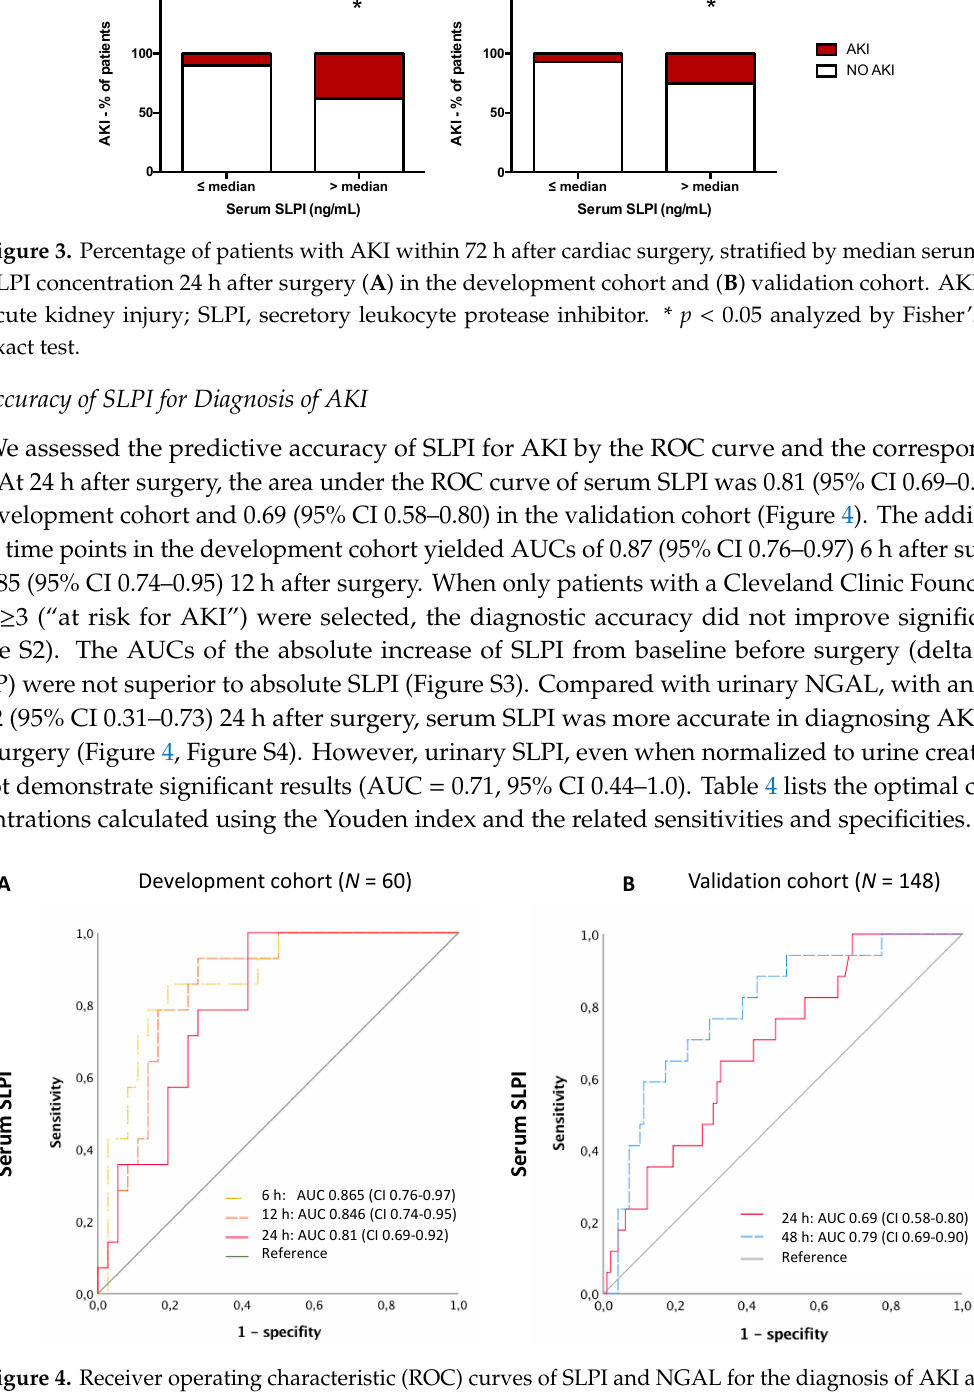
Figure 2. Higher serum SLPI levels were associated with a greater risk of AKI. ( A,B ) Perioperative kinetics of serum SLPI in patients without postoperative AKI compared with patients with AKI. ( C,D ) Perioperative kinetics of urinary SLPI. ( E ) Correlation between postoperative urinary SLPI and